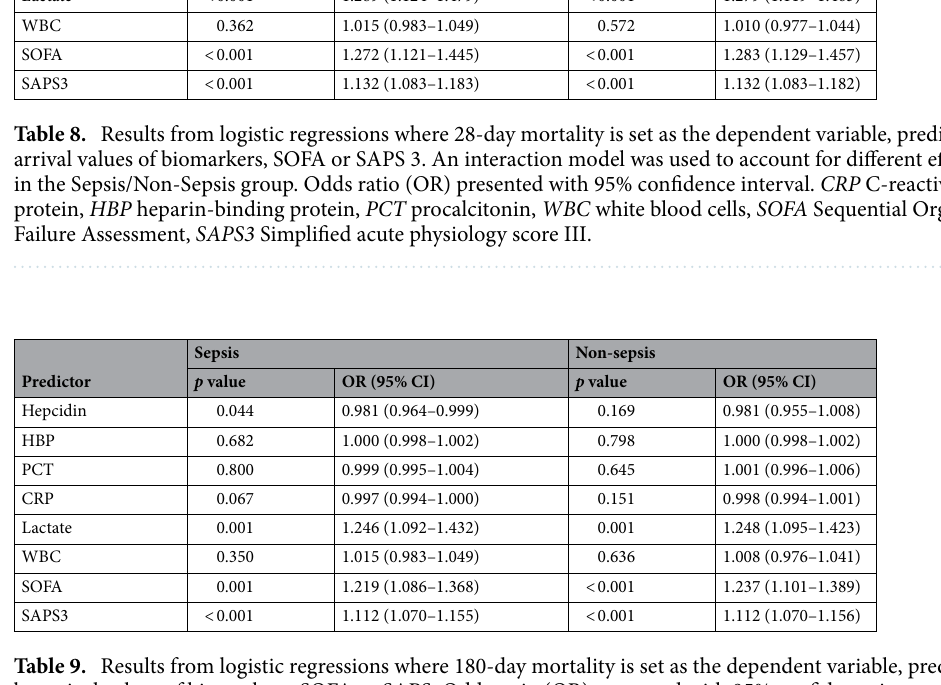
Table 9. Results from logistic regressions where 180-day mortality is set as the dependent variable, predicted by arrival values of biomarkers, SOFA or SAPS. Odds ratio (OR) presented with 95% confidence interval. CRP C-reactive protein, HBP heparin-binding protein, PCT procalcitonin, WBC white blood cells, SOFA Sequential Organ Failure Assessment, SAPS3 Simplified acute physiology score III.